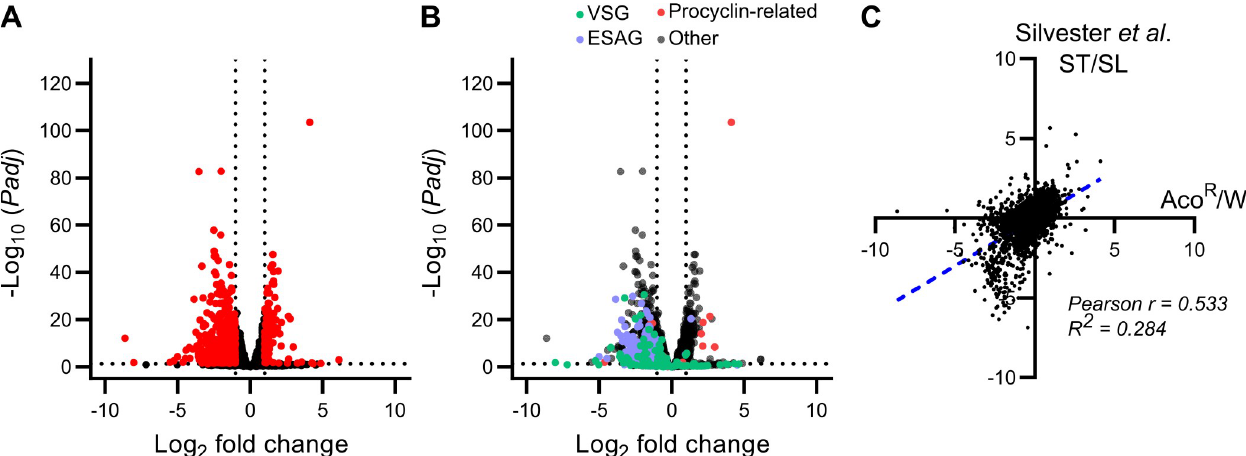
Fig 2. Overview of transcriptomics analysis of the Aco R cell line. A) Volcano plot of statistical significance ( Padj < 0.05) against fold change (Log 2 fold change < -1 or > 1) between Aco R and wild-type cells. Differentiation expression was calculated using DESeq2 [66]. Transcripts undergoing significant differential expression based on the aforementioned parameters are highlighted in red. B) Volcano plot of the same RNAseq data highlighting changes in expression of life-cycle stage-specific surface proteins. Green data points are genes whose production descriptions match “VSG”, whilst purple points indicate BSF-associated expression sites (ESAGs). Finally, red data points indicate genes whose annotation include “procyclin”, which includes GPEET and EP procyclin. C) Data from this study was compared to previously published transcriptomics data comparing stumpy (ST) form to slender (SL) form T . brucei [13]. Raw data from the Silvester et al . study [13] was processed by the same means as the data generated here (Aco R vs wild-type; WT), and log 2 fold change (as calculated by DESeq2) of Aco R /WT was compared to ST/SL by linear regression (R 2 ; blue dotted line) and correlation (Pearson’s r).